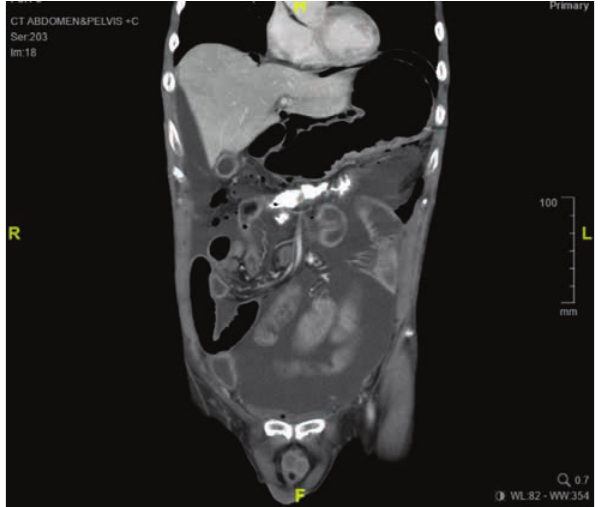
Figure 2: (Case 1) Two days after the distal loopogram was done, patient presented with generalised peritonitis and his CT abdomen showed gross ascites and pneumoperitoneum.